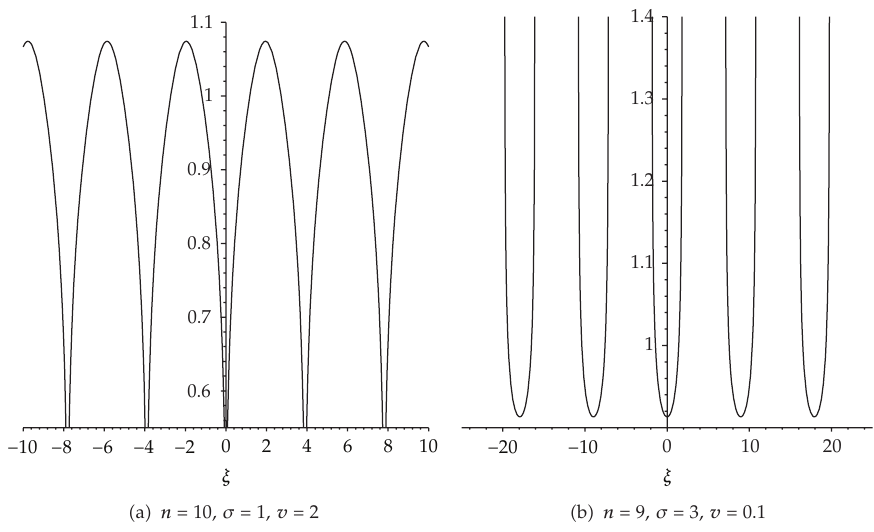
Figure 4: Two di ff erent periodic waves on solutions (cid:2) 3.30 (cid:3) and (cid:2) 3.31 (cid:3) for given